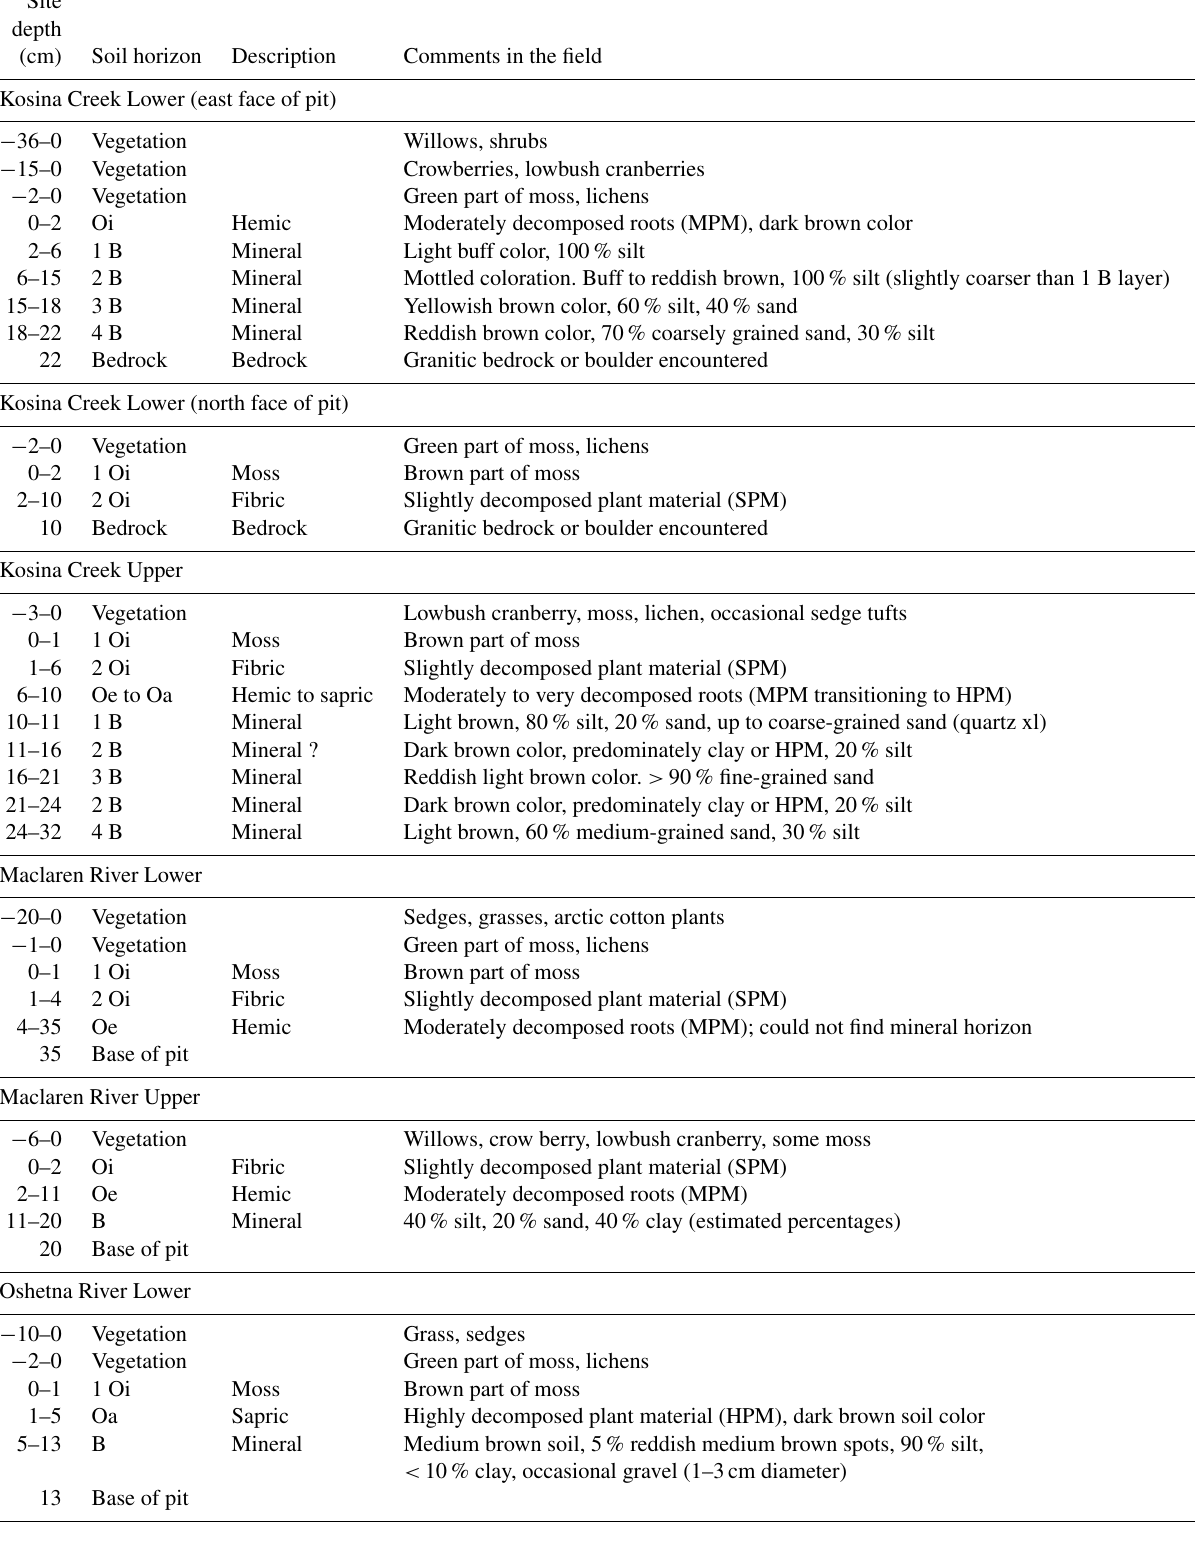
Table A2. Soil pit